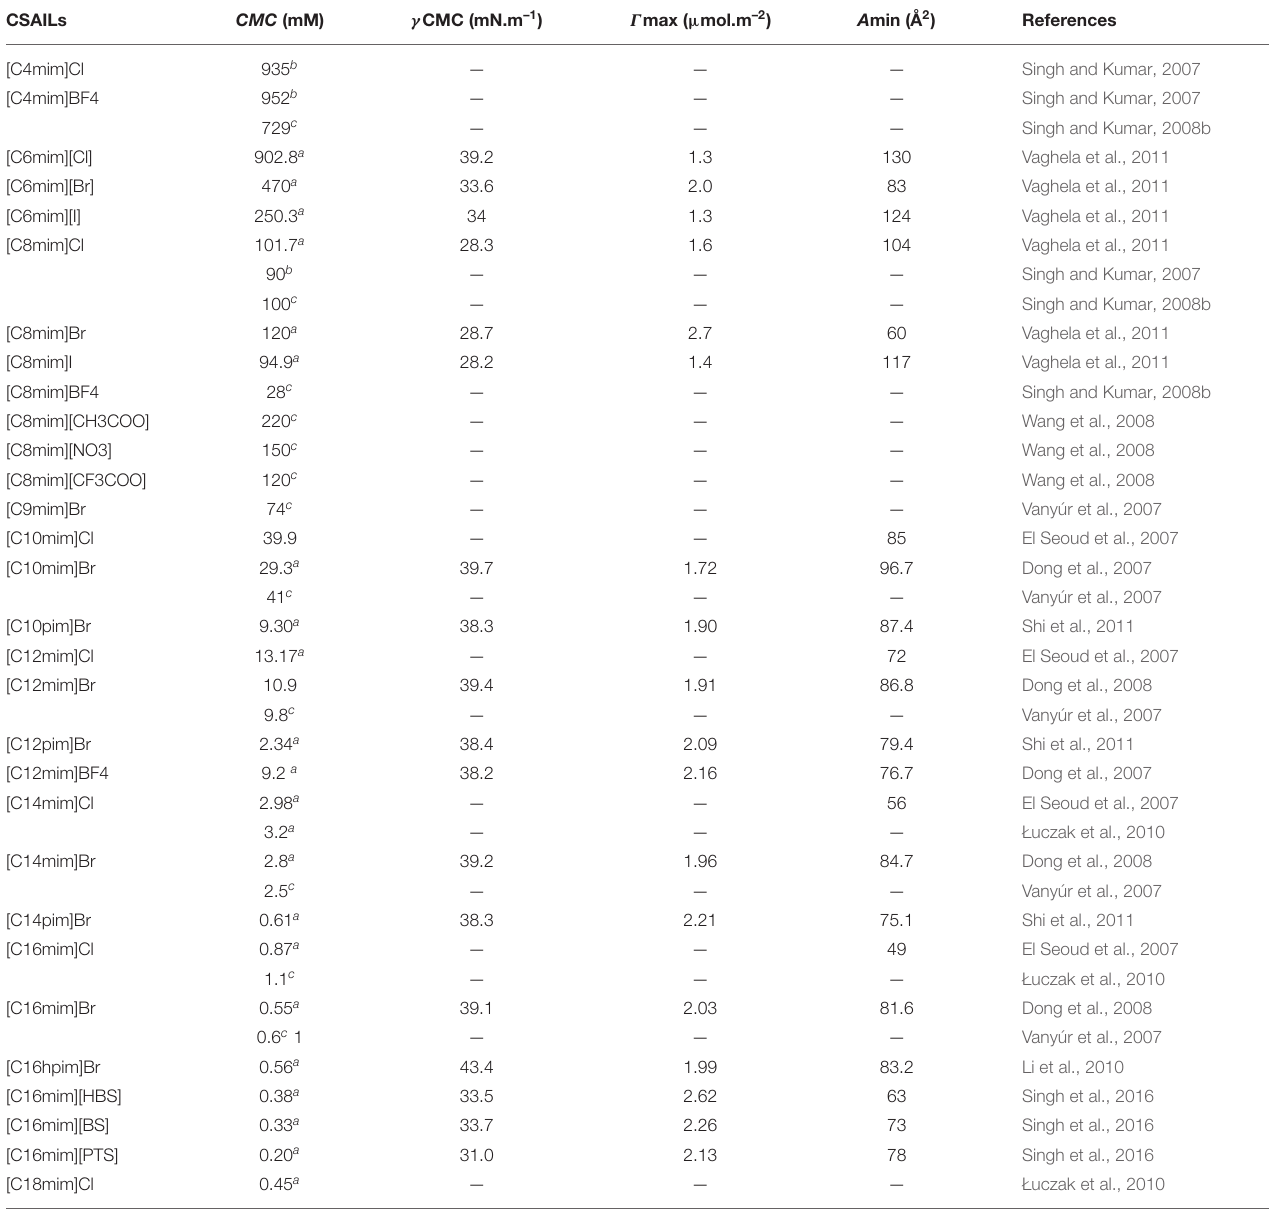
TABLE 2 | Reported values of critical micelle concentration (CMC), the surface tension at CMC ( γ CMC), surface excess concentration ( Γ max), and minimum area per molecule at air–water interface ( A min) for cationic surface-active ionic liquids (CSAILs) at 298.15K in aqueous medium.